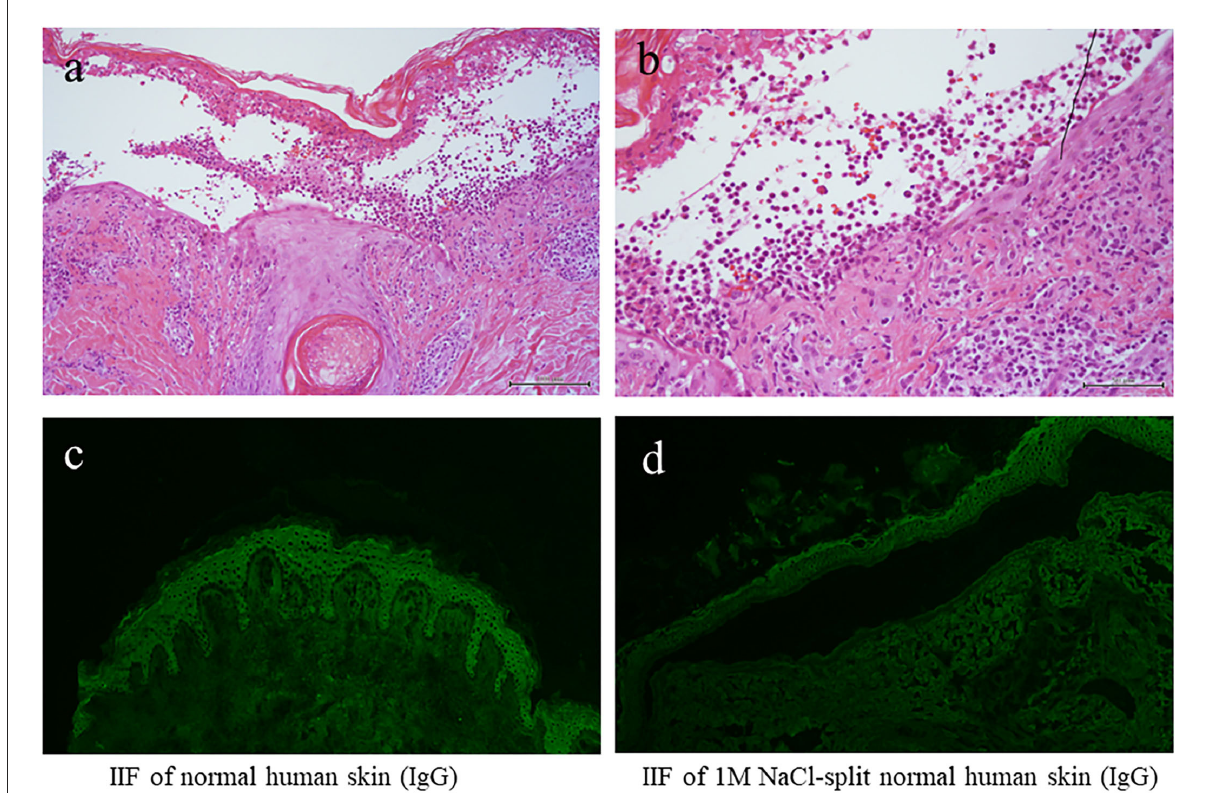
FIGURE2 The results of histopathology and IF tests. (a,b) Histopathological features [H&E staining; magnifications: (a) x100; (b) x200]. (c) The results of indirect IF of a normal human skin section. (d) The results of indirect IF of 1M NaCl split skin section. IF, immunofluorescence.